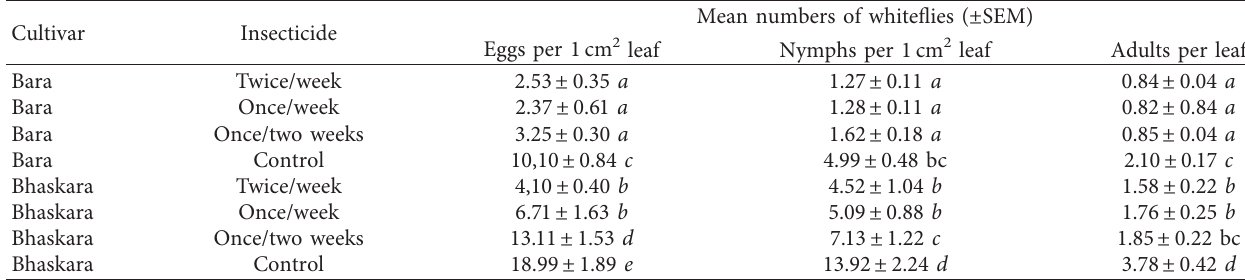
Table 6: Influence of cultivar and insecticide application frequency treatments on the average numbers of whitefly eggs, nymphs, and adults across mulches,